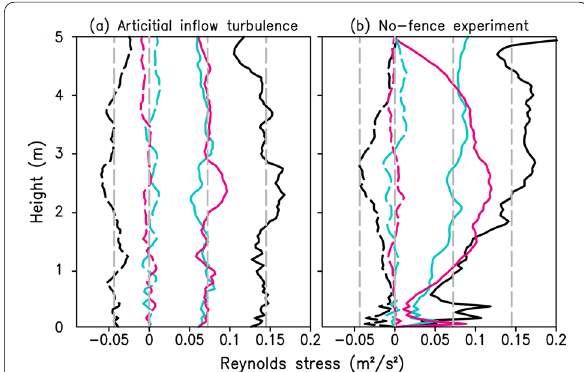
Fig. 5 Vertical profile of six components of Reynolds stress a in the artificial inflow turbulence at the center of the y -axis and b in the no-fence experiment at ( x , y ) (3.5 m, 2.5 m). Solid lines are = v ′ v ′ w ′ w ′ (black), (blue), and (pink). Broken lines are � � � � u ′ v ′ v ′ w ′ (blue), and (pink). The grey dotted line indicates the � � � � target values of